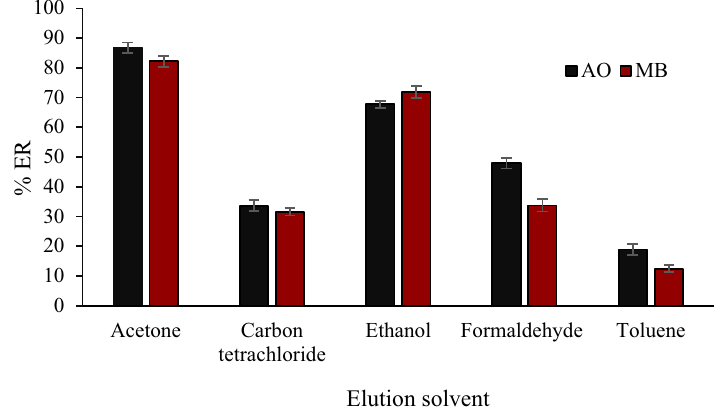
Figure 2. The effect of organic phase composition on the extraction efficiency (Extraction conditions: pH = natural, dye concentration 500 ng mL −1 , adsorbent mass 0.03 g, and ultrasound time 5